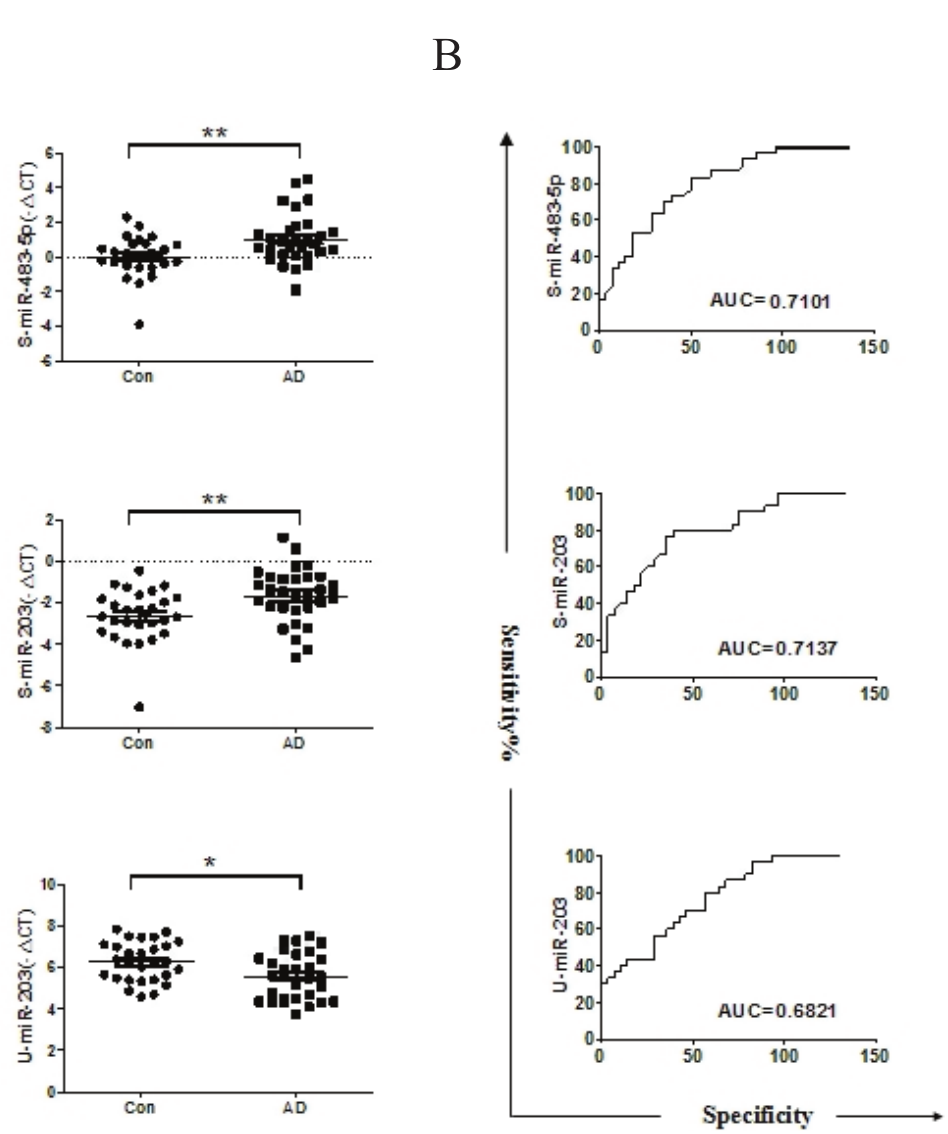
Fig. 2. Validation of selected miRNA expression levels. A . Expression of two miRNAs in serum (S-miR-483-5p and S-miR-203) and one in urine (U-miR- 203) were measured by quantitative real-time PCR were in 30 children with AD and 28 healthy children. The 2 - gg CT method in one subject with children with AD was normalized to 1. miR-374a expression was considered as control. *P , 0.05, **P , 0.01. B . ROC and AUC analysis for the ability of serum miRNAs (S-miR-483-5p and S-miR-203) and urine miRNA (U-miR-203) were performed. ROC Curve analysis shows the sensitivity (y-axis) and specificity (x-axis) of a standard of potential